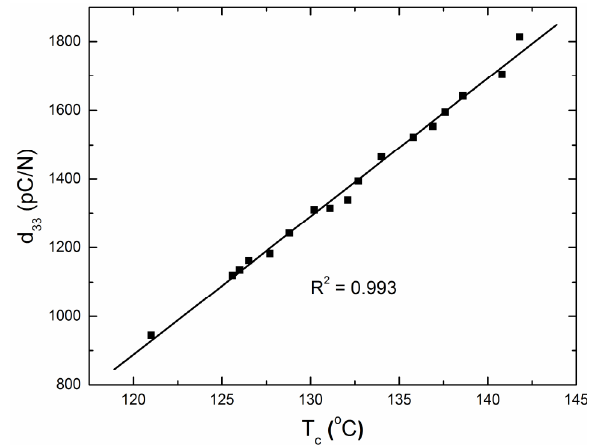
Figure 4. Piezoelectric property of crystals along growth